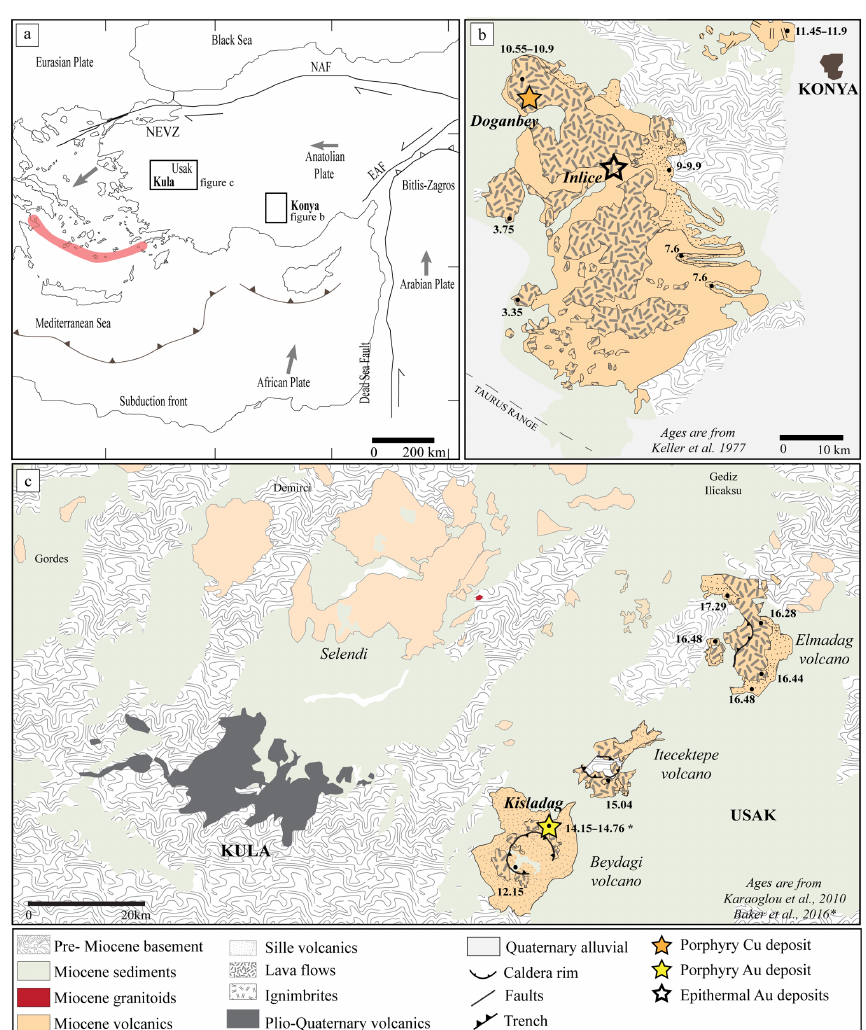
Figure 2. Tectonic (a) and geological maps (b–c) of the studied areas and associated Au epithermal and Cu–Au porphyry deposits in western Anatolia. The investigated Miocene volcano–plutonic complexes are Konya (b) and the volcanoes of the Usak basin (Elmadag, Itecektepe, and Beydagi – c ) as well as the Quaternary Kula volcano (c) . The geological maps have been modified after (b) Keller et al. (1977) and (c) Karao˘glu et al.